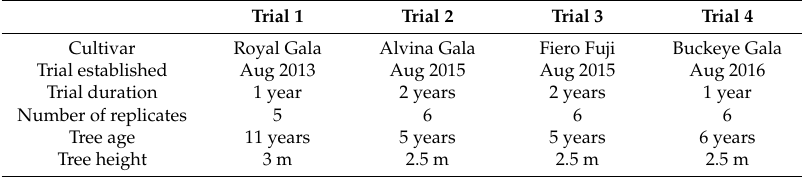
Table 1. Cultivars, tree age, trial duration and establishment dates for Trials 1 to